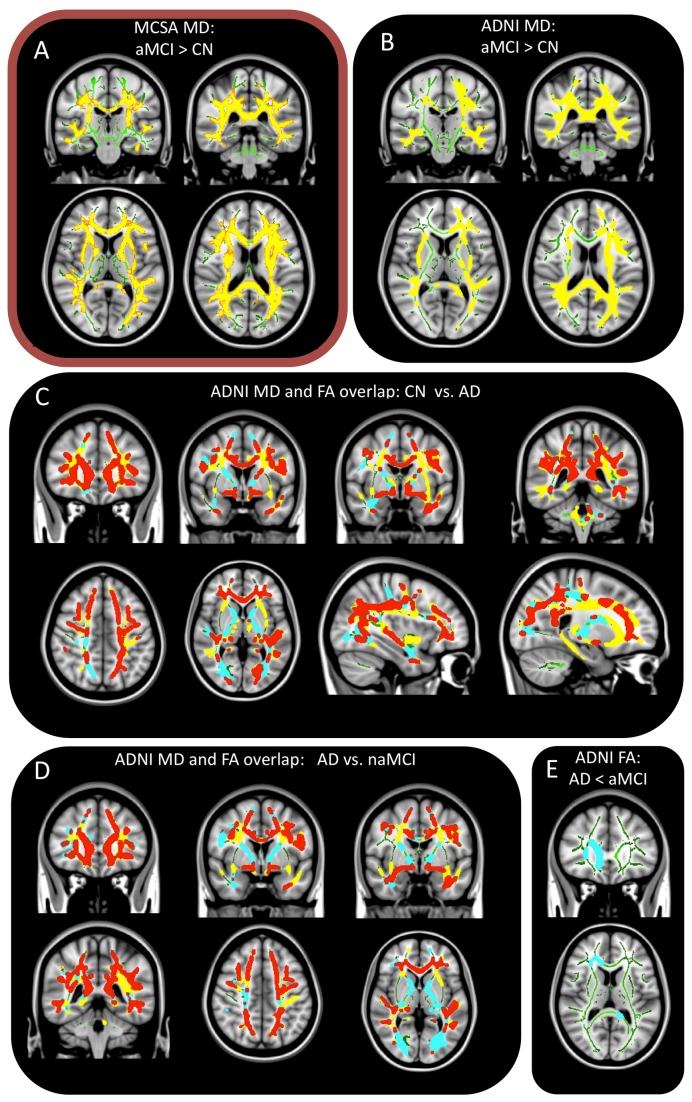
FA and MD group statistics.All parts display voxels showing abnormal FA and MD on TBSS skeleton. Statistically significant group differences of MD (yellow), FA (blue) are shown. A shows the aMCI>CN contrast for the MCSA cohort while B-E show contrasts from the ADNI cohort. Notice C and D show overlap of MD and FA in red. Contrasts not shown were not significant.